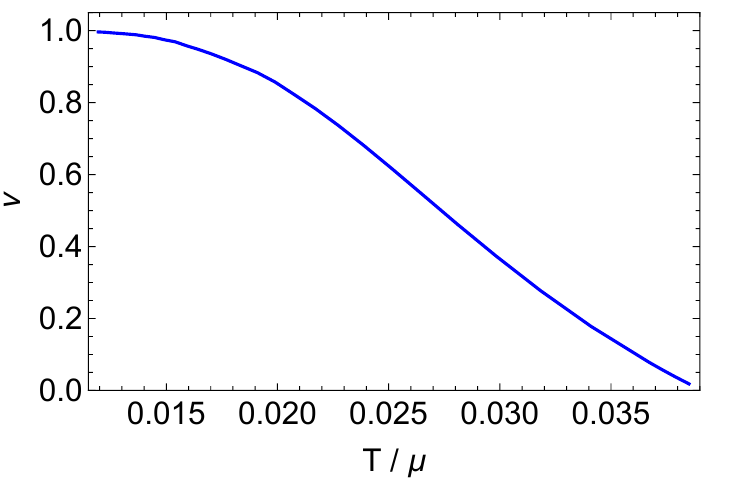
Figure 7 . The T=(cid:22) dependence of the parameter (cid:23) , which characterizes the pro(cid:12)le of the Jacobi elliptic